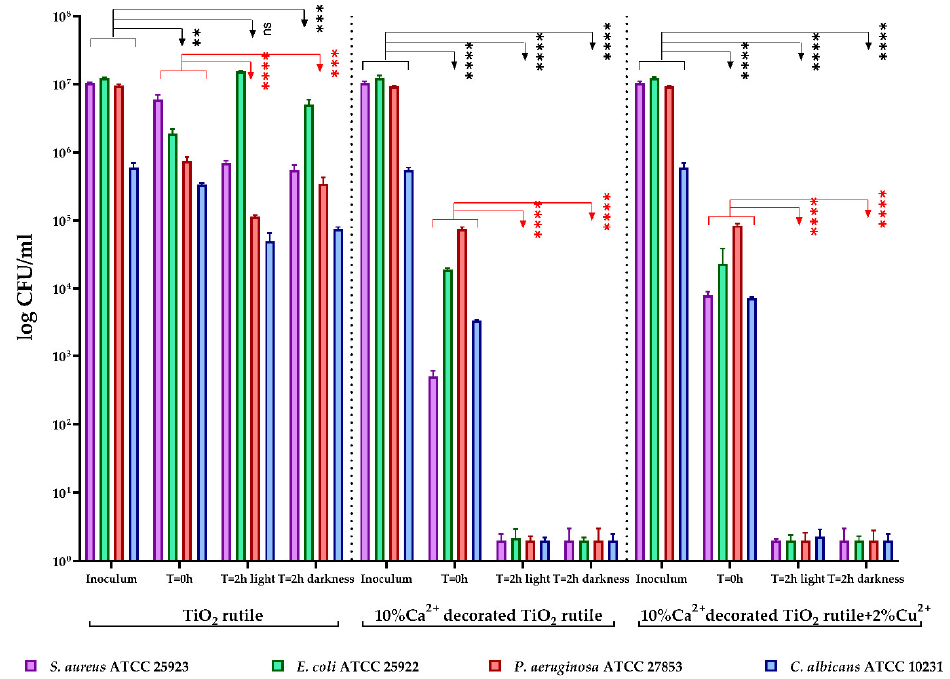
Figure 11. Graphical representation of the log10 values of colony-forming units (CFU)/mL representing the viable cell number after 2 h of contact with the tested products under two conditions: visible light and darkness. The results were compared using two-way ANOVA and Dunnett’s multiple comparisons tests. The results were considered statistically significant (ns—not significant, ** p = 0.0011; *** p < 0.0004; **** p < 0.0001).